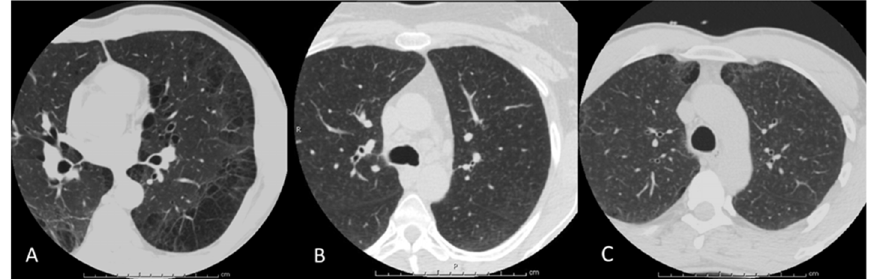
Figure 2. A Representative Image of a Subject with Emphysema (A), a Subject with Bronchiolits (B), and a Subject with both Emphysema and Bronchiolitis (C). A) A transverse axial image of a 48 year old HIV-infected male, displaying changes of severe emphysema as manifested by large bullae, as well as paraseptal and centrilobular regions of low attenuation. B) An axial image reconstructed with a small field of view in a 42 year old HIV-infected female, demonstrating changes of moderate respiratory bronchiolitis with multiple centrilobular nodules scattered throughout both lungs. C) A transverse axial image of a 44 year old HIV-infected male shows changes of both moderate emphysema and